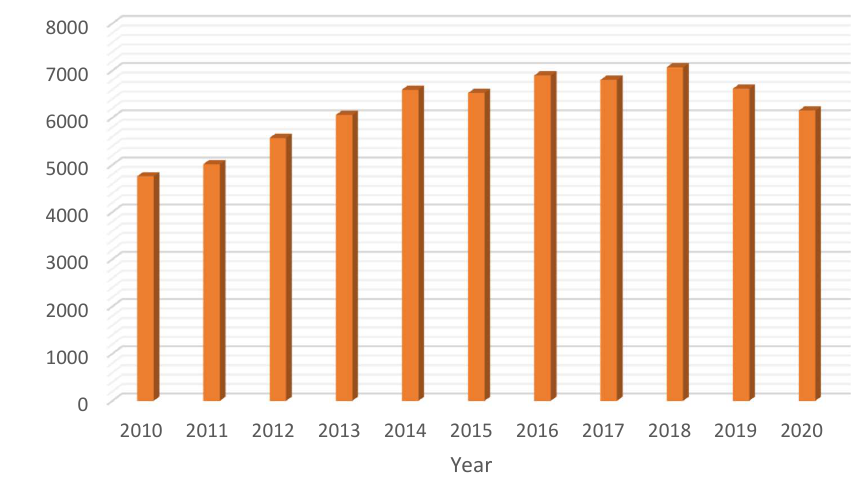
Figure 1. Rising interest on the use of ionic liquids: yearly number of publications in the domain of ionic liquids in the 2010–2020 period (Database: Scopus, search terms: “ionic” AND “liquids”, search date: 7 November 2020).